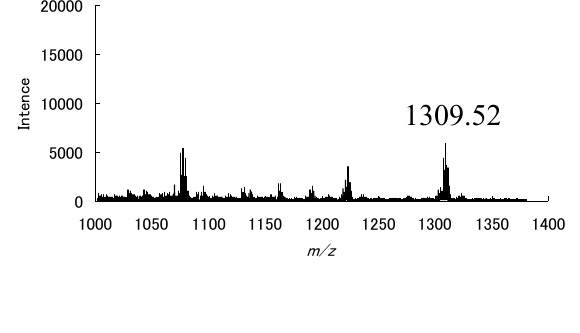
Figure 6. APPI MS spectrum of zwitterionic fullerodendron 12a